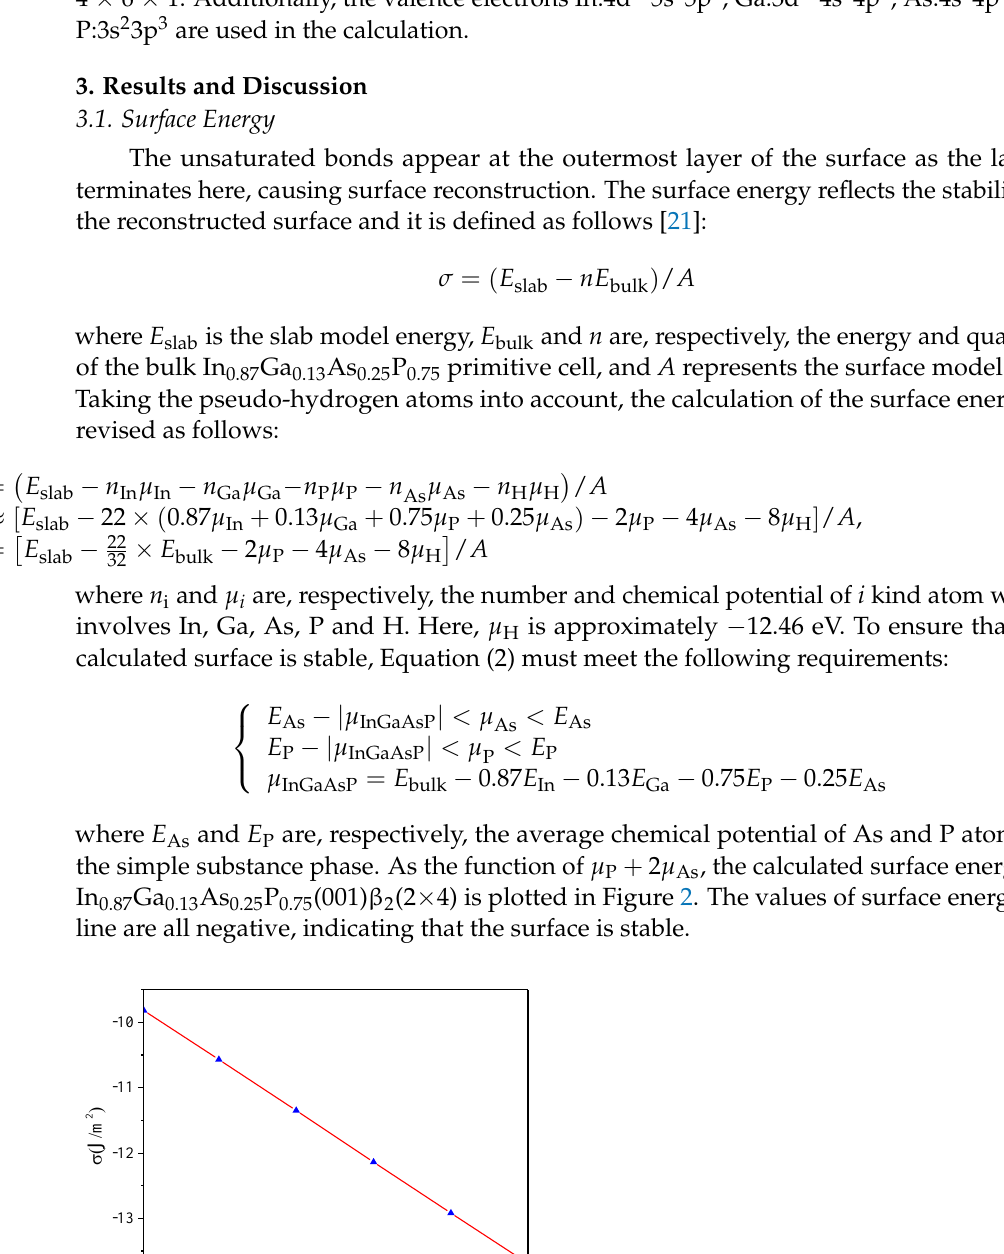
× 4) surface β 2 (2